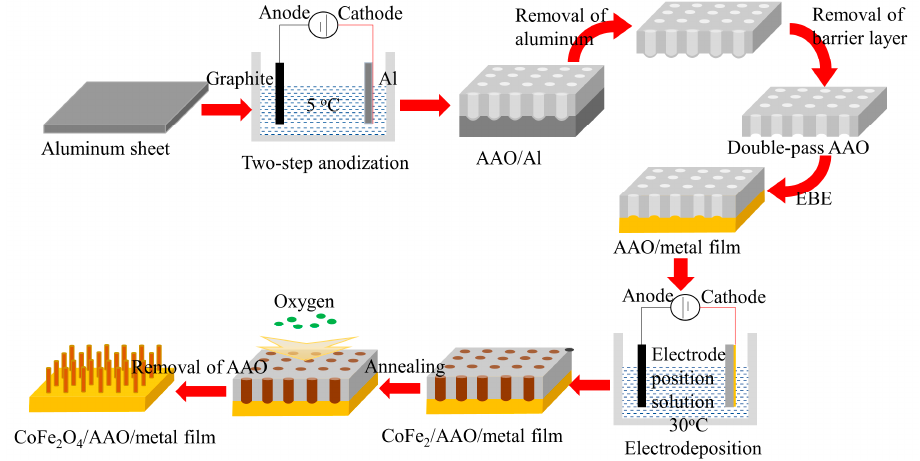
Figure 1. Schematic diagram of synthesis mechanism of the CFO nanowire.